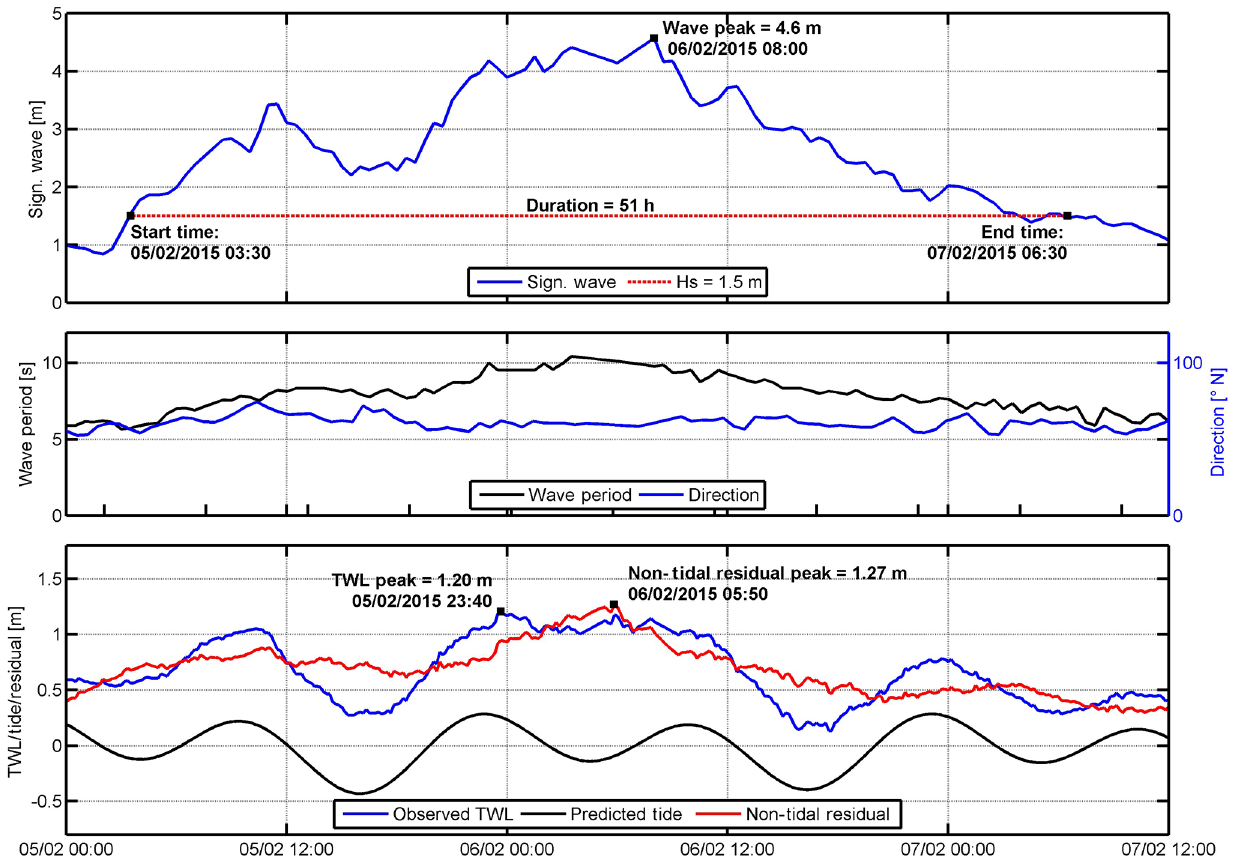
Figure 2. St Agatha storm hydrodynamic data including significant wave height (m), wave period (s), direction of waves (nautical degrees), total water level (m), predicted tide (m), and non-tidal residual (m). The start and end times of the storm are referenced to the local storm threshold condition of H s = 1 . 5m and referenced to